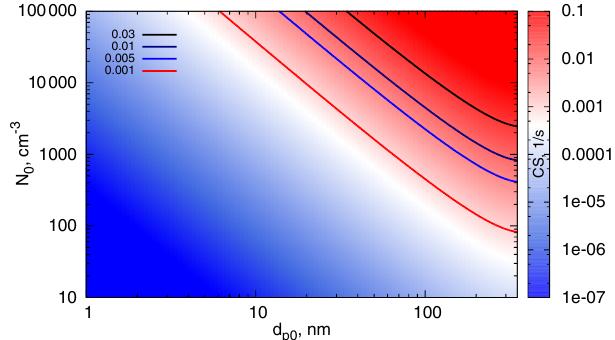
Figure 8. A diagram showing the condensation sink (CS) as a func- tion of the geometric mean diameter of the aerosol mode( d p0 ) and the particle number concentration, N 0 , for σ 0 = 1 .